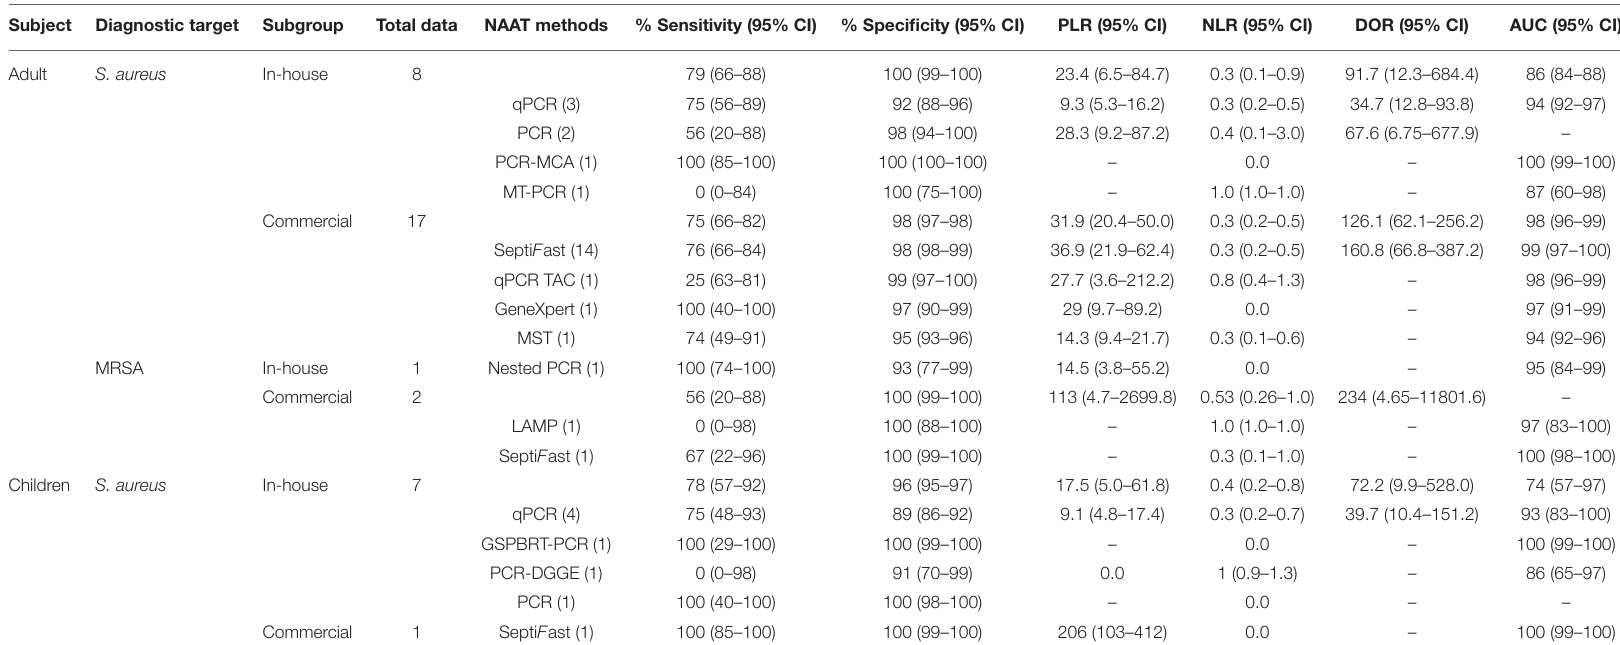
TABLE 2 | Subgroup analysis of studies based on different NAA